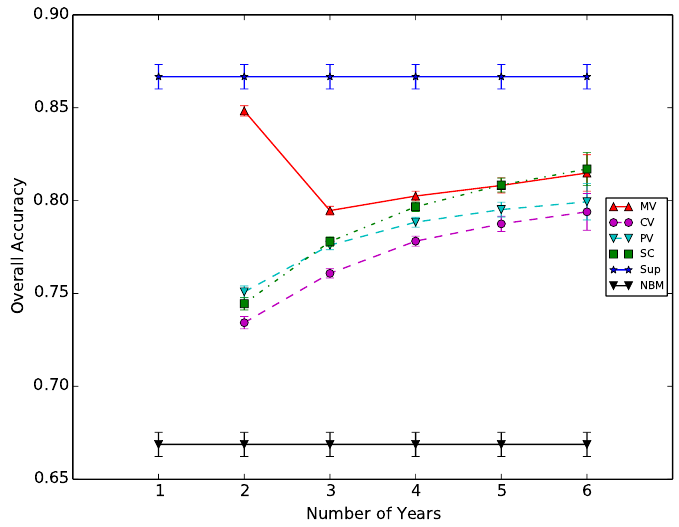
Figure 6. Overall accuracy of each method for different numbers of time series available in the history. Each point represents the average of all runs for all possible subsets. The confidence interval represents 90% of the values obtained. The following abbreviations are used: MV, CV and PV for Majority, Confidence and Probability Voting, respectively, and SC for the Single Classifier; Sup and NBM for the standard Supervised and the Naive